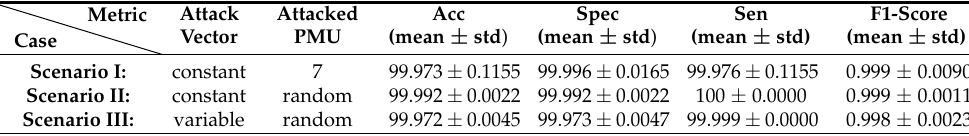
Table 2. The mean and standard deviation of the PLV performance for the IEEE-14 bus system.